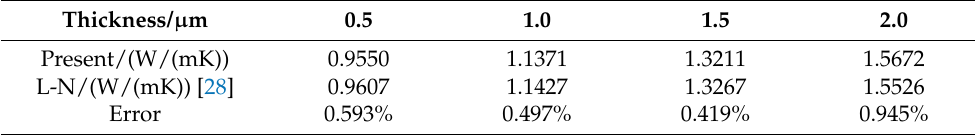
Figure 6. Distributions of ( a ) temperature, ( b ) the heat flow of RVE 3 , ( c ) the heat flow of the yarns and ( d ) the heat flow of the matrix under a temperature gradient 1 C and ( d ) the heat flow of the matrix under a temperature gradient Table 5. Comparison of results between FEM and L-N